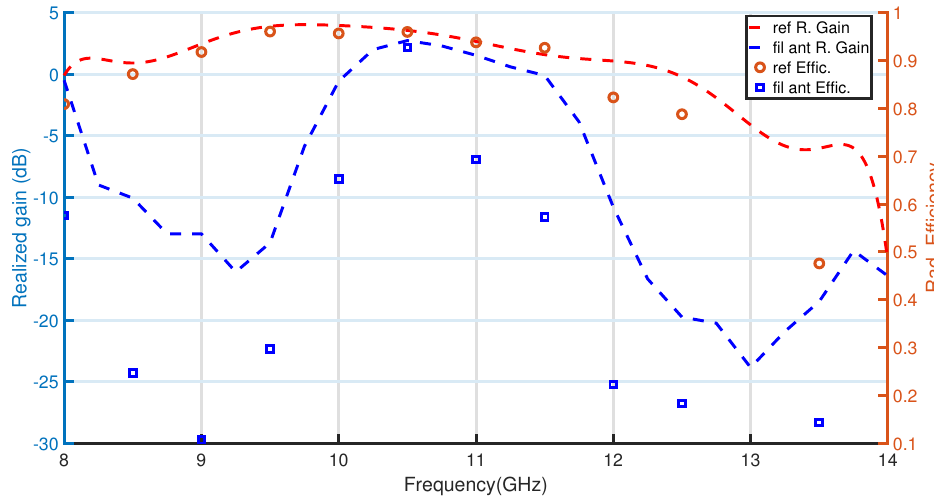
Figure 22. Simulated radiation efficiency and antenna realized gain of the filtering antenna in comparison with the reference